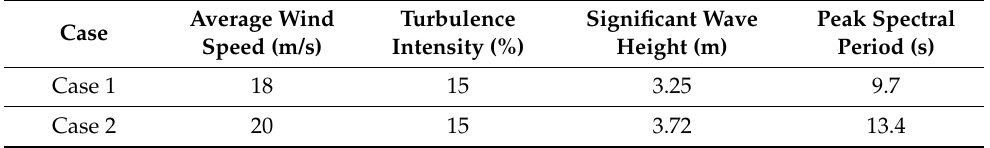
Table 2. External environmental parameters.